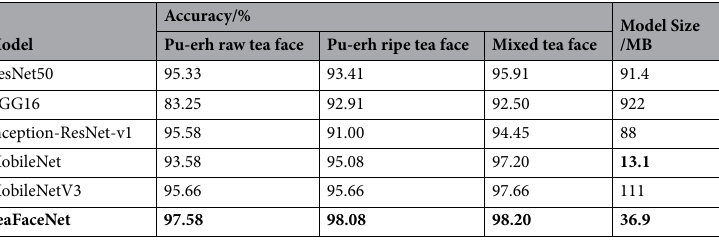
Table 6. Tea face verification results. Significant are in value